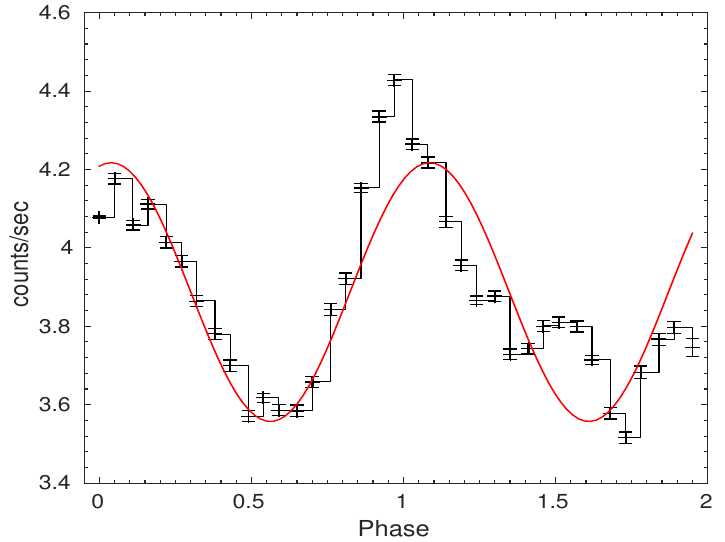
Figure 4. Folded 3–79 keV light curve with a period = 143,000 s and the best-fit sinusoidal curve in red solid